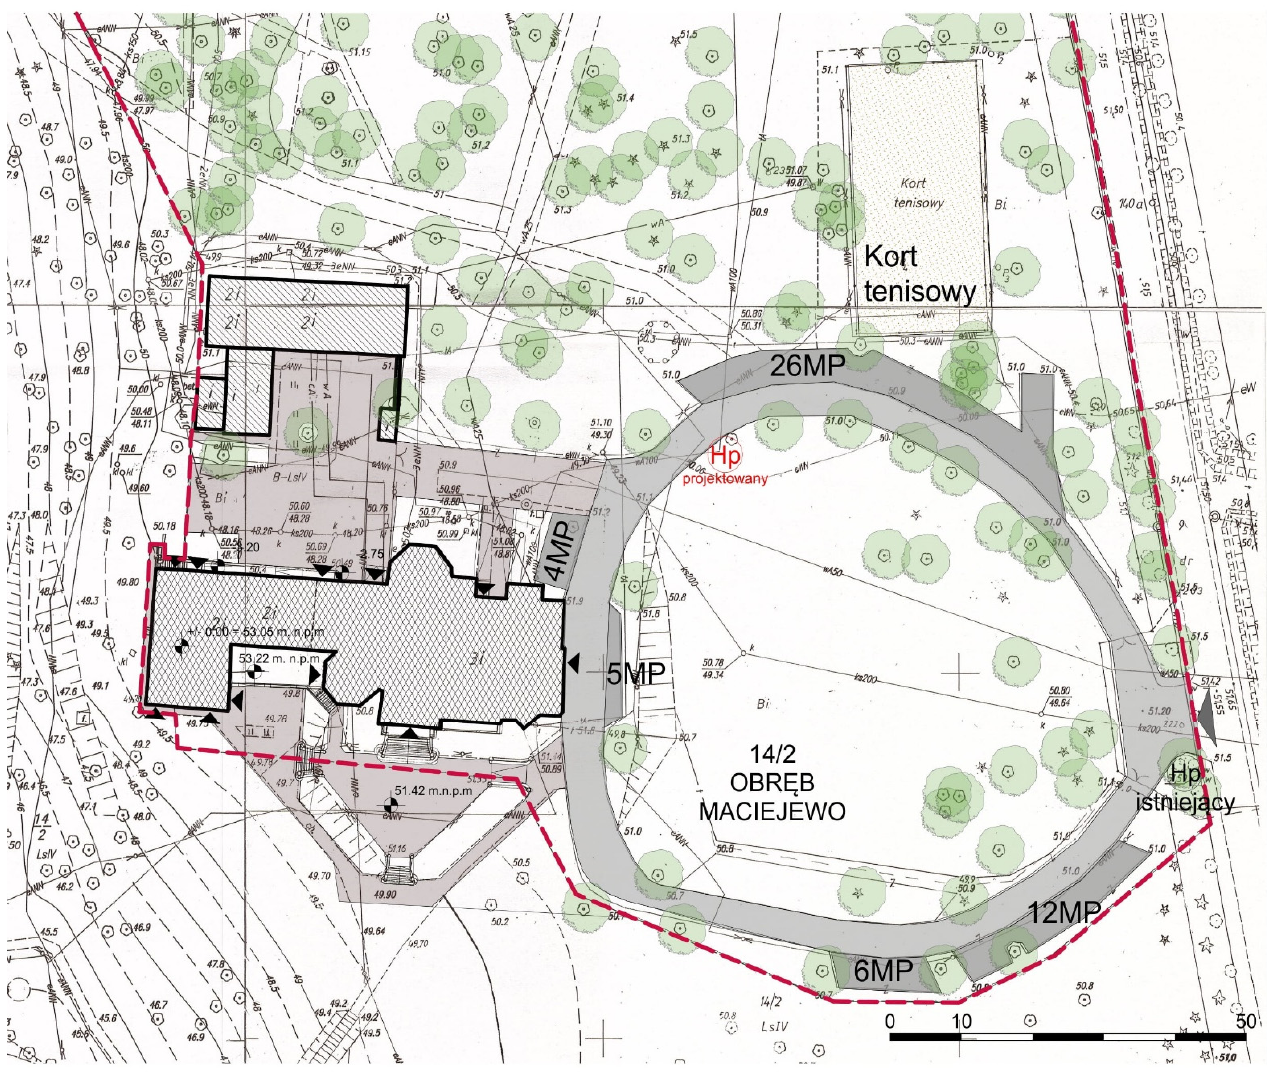
Figure 6. Development project of the surroundings of the Palace in Maciejewo; development by Urbicon Sp ó łka z o.o. Szczecin; photo: author.